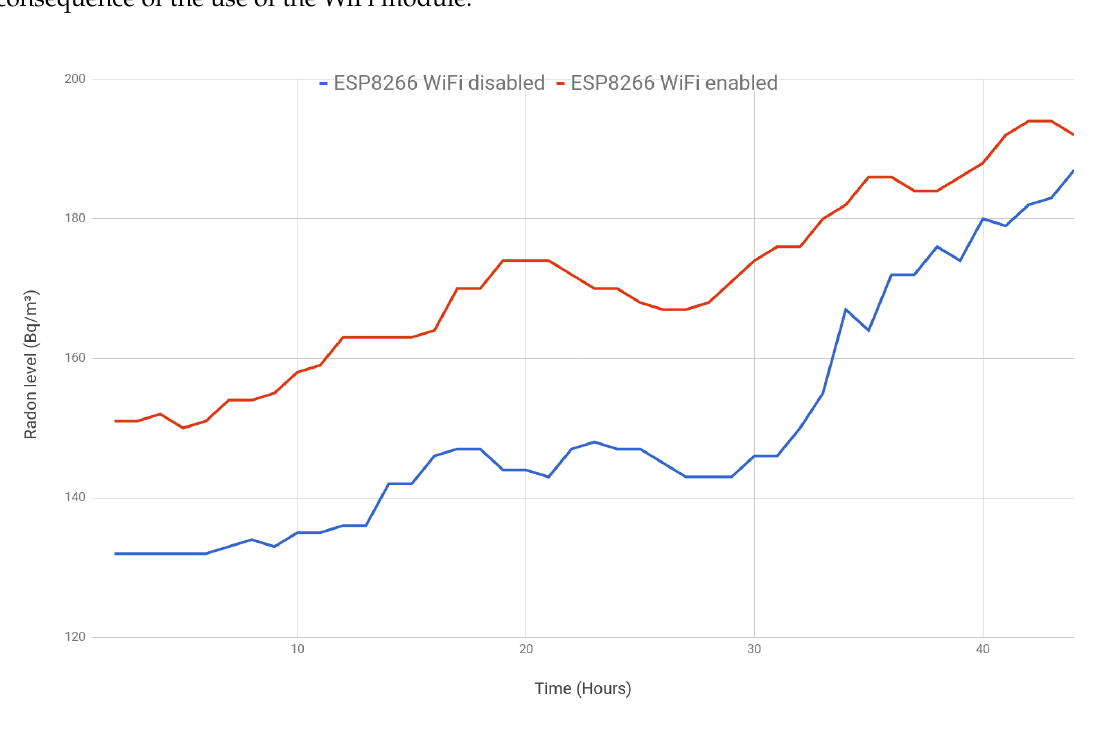
Figure 15. ESP8266 with WiFi enabled vs. ESP8266 with WiFi